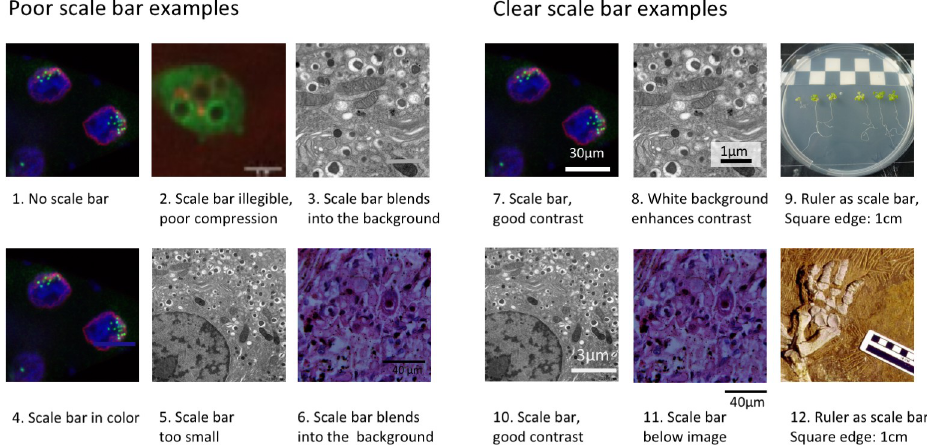
Fig 4. Using scale bars to annotate image size. Scale bars provide essential information about the size of objects, which orients readers and helps them to bridge the gap between the image and reality. Scales may be indicated by a known size indicator such as a human next to a tree, a coin next to a rock, or a tape measure next to a smaller structure. In microscope images, a bar of known length is included. Example images were created based on problems observed by reviewers. Poor scale bar examples (1 to 6), clear scale bar examples (7 to 12). Images 1, 4, 7: Microscope images of D . melanogaster nurse cell nuclei [18]; 2: Microscope image of Dictyostelium discoideum expressing Vps32-GFP (Vps32-green fluorescent protein shows broad signal in cells) and stained with dextran (spotted signal) after infection with conidia of Aspergillus fumigatus ; 3, 5, 8, 10: Electron microscope image of mouse pancreatic beta- islet cells (Andreas Mu¨ller); 6, 11: Microscope image of Lendrum-stained human lung tissue (Haraszti, Public Health Image Library); 9: Photo of Arabidopsis thaliana ; 12: Photograph of fossilized Orobates pabsti